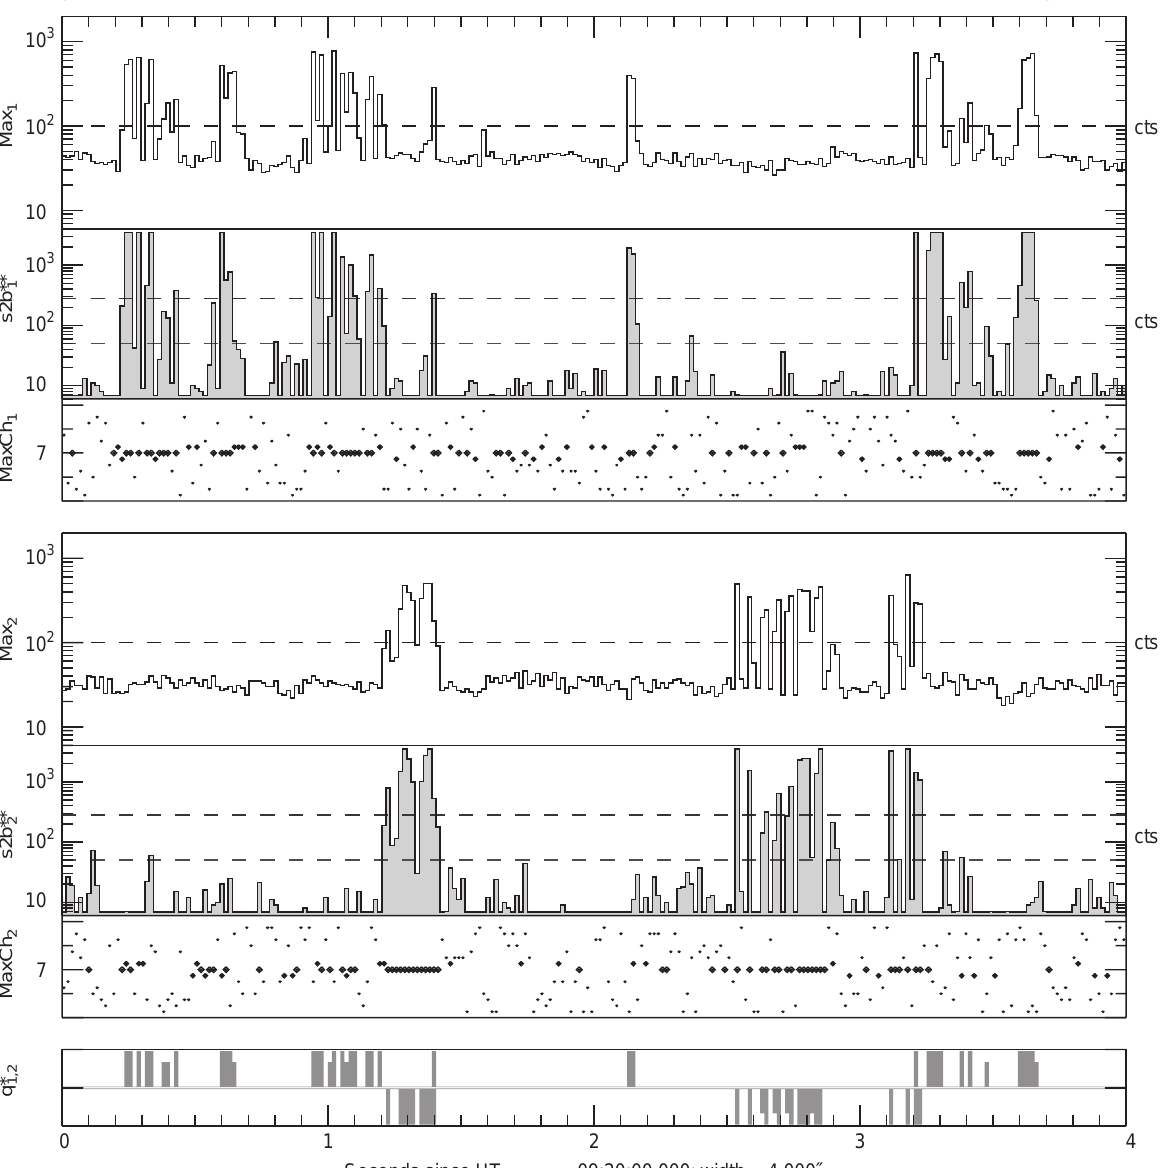
Fig. 3. EDI-detected signals, during a 4-s period on April 28, 1998, for detectors 1 and 2 ( subscripts ). ‘‘ Max ’’ shows the detected counts in the correlator channel with the highest counts during a 1 ms period (sampled at 16 ms intervals). ‘‘ s2b ’’ is a derived indication of signal (beam electrons) strength compared to the background (ambient